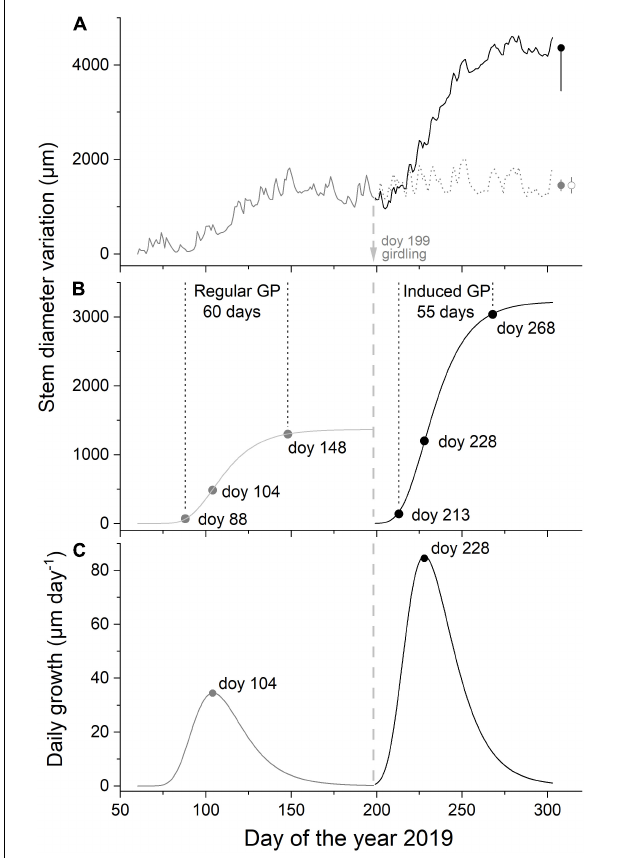
FIGURE 2 | Time series of mean daily dendrometer records. Regular growth (pre-girdling, n = 7) and induced growth (post-girdling, n = 3) are given in gray and black lines, respectively. Dendrometer record of the non-girdled subset of trees ( n = 4) is shown in dashed gray line (A) , modeled intra-annual radial growth by applying the Gompertz function in ( B ; for parameters, see Table 2 ), and daily growth pre-girdling and post-girdling calculated from Gompertz function in ( C ; GP, growth period). Arrow indicates time of girdling. Bars in (A) depict standard errors of mean daily dendrometer records during the last 25